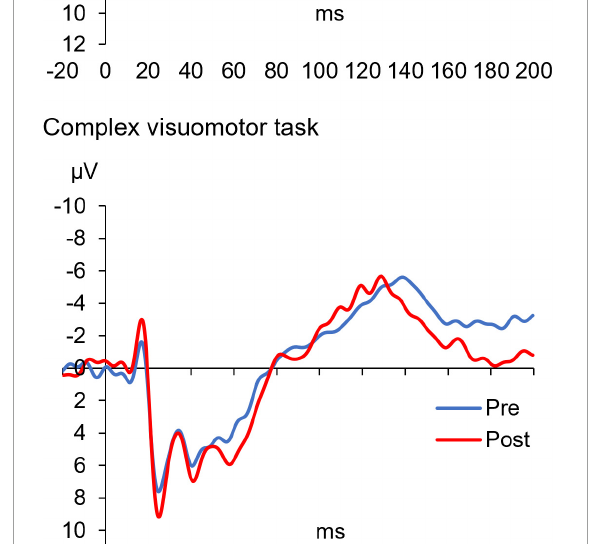
FIGURE5 The SEP waveforms before and after training in two representative subjects under each condition. The blue and red lines indicate the SEP waveform before and after motor learning, respectively. These results indicate that the amplitude (N20/P25) of the SEP waveform after motor learning did not change in the simple visuomotor task but increased in the complex visuomotor task.